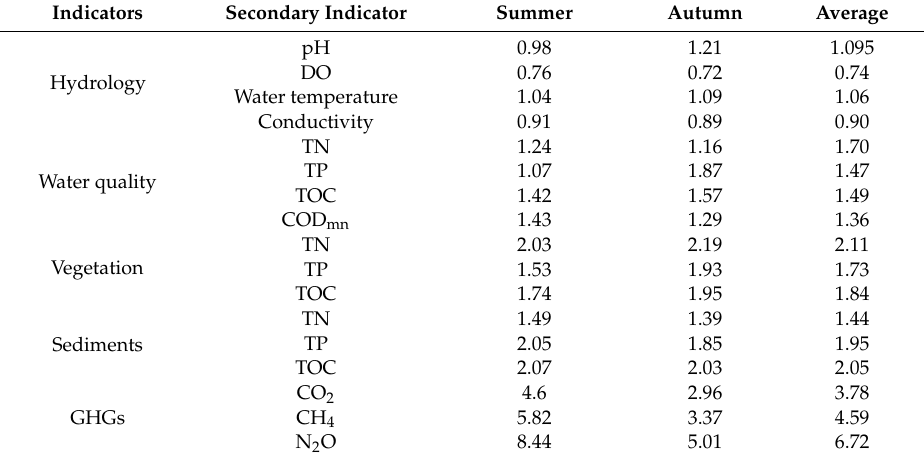
Table 1. ACs of environmental indicators and GHGs in the Huoshaogou River.